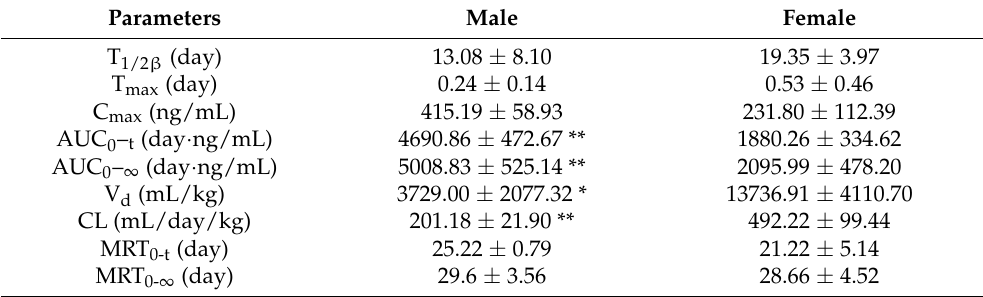
Table 3. Pharmacokinetic parameters of MXD obtained from male and female Qinghai Tibetan sheep.